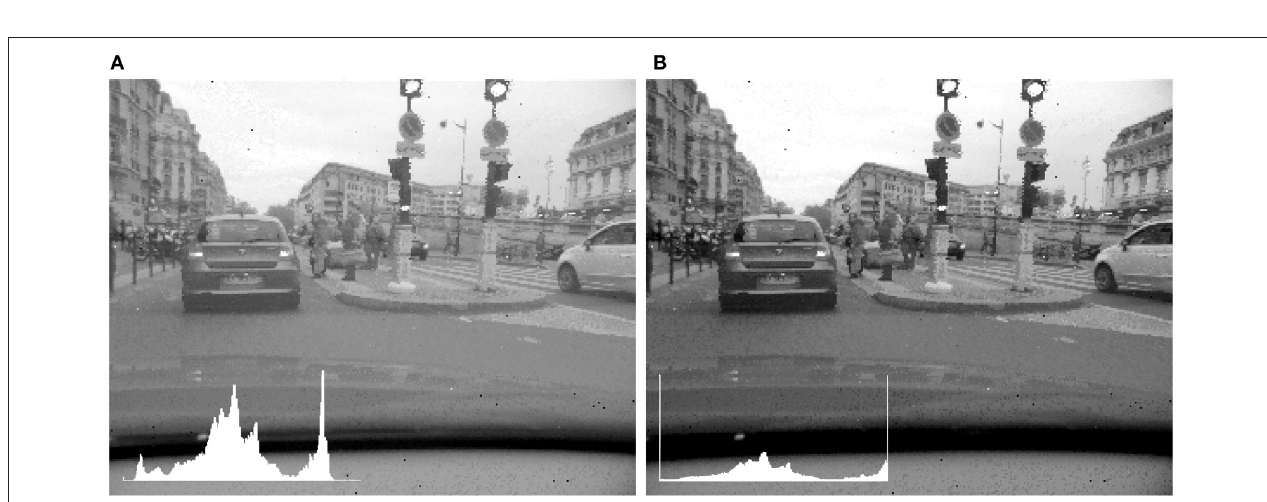
FIGURE 4 | Logarithmic tone mapping with increasing percentage of high and low values excluded from scaling. (A) 1%. (B) 5%. Insets: Image histogam. In addition to an improved contrast in the left image, the difference between the two images is most notable in the representation of the sky and clouds.